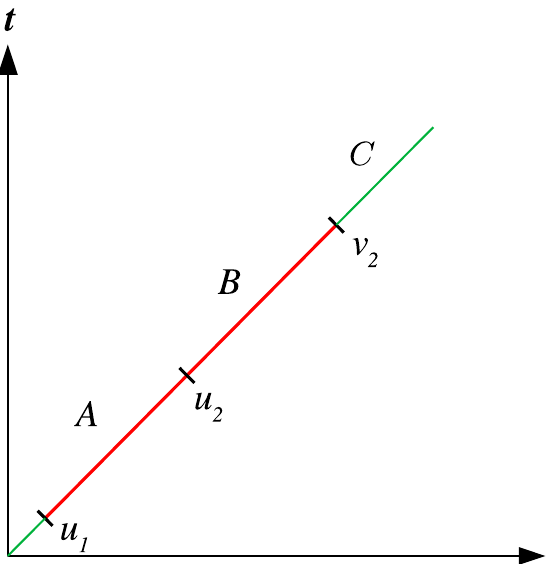
Fig. 4 Two adjacent intervals in a GCFT 1 + 1